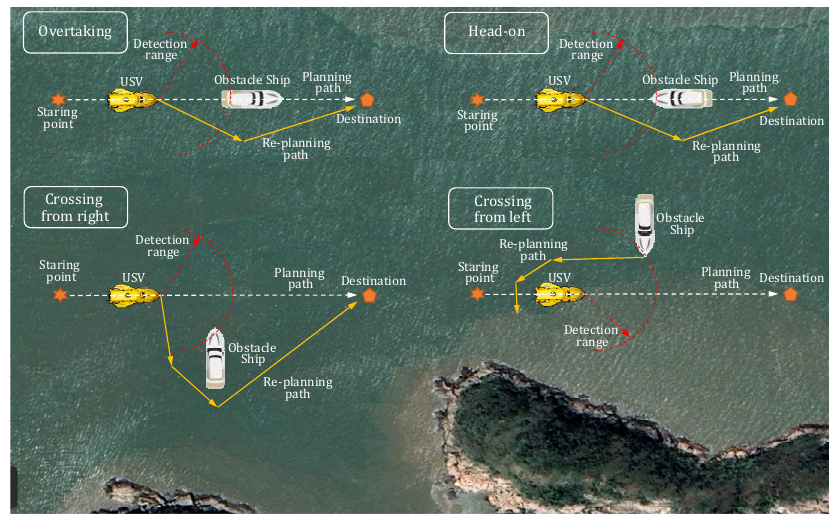
Figure 3. Encounter scenario partitioning schematic.